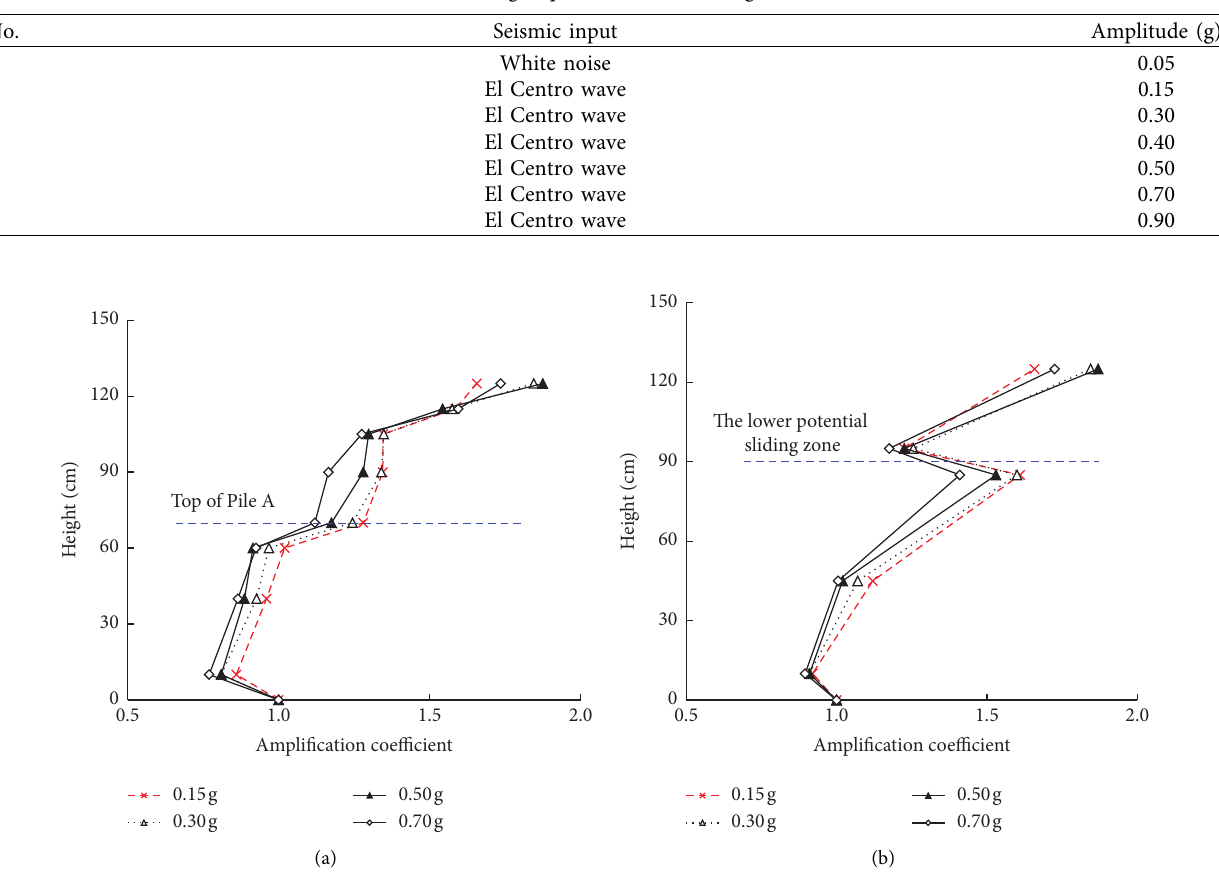
Table 4: Loading sequence for the shaking table